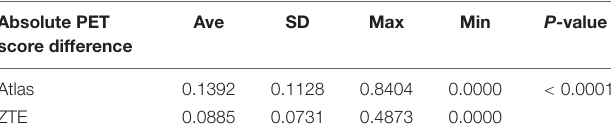
TABLE 1-C | Absolute PET score difference (| PETscore MRAC - PETscore original |) in each 2889 simulated dataset.